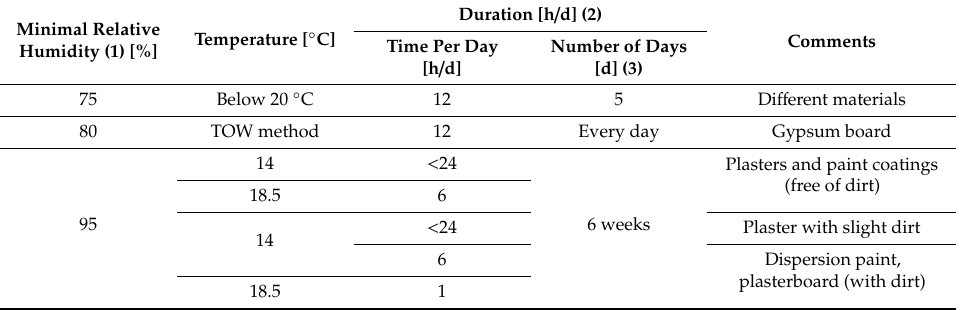
Table 1. Dependence of fungi growth on hygrothermal and other conditions